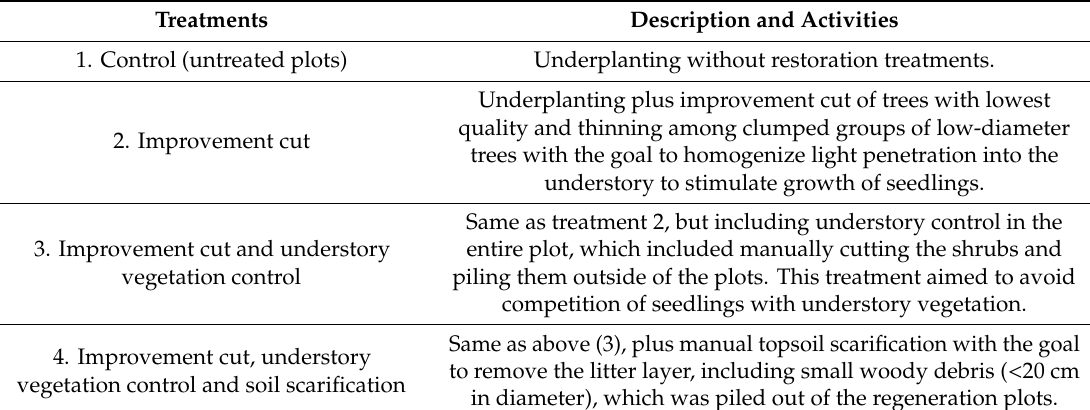
Table 2. Description of the restoration treatments implemented in the